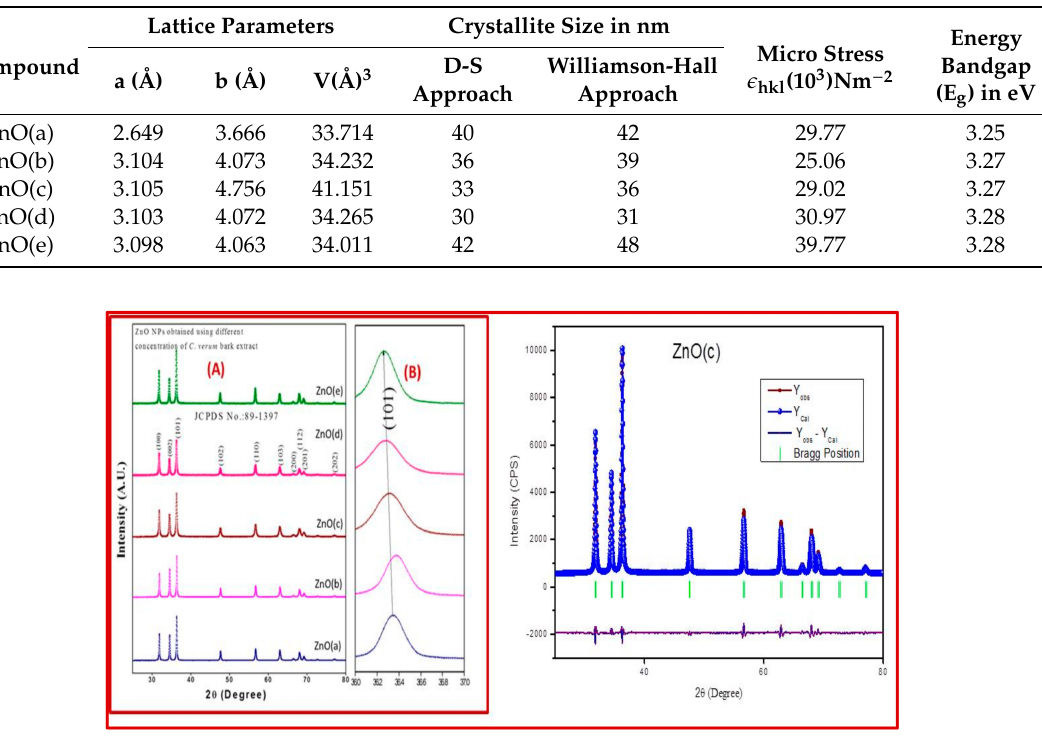
Figure 3. PXRD patterns of ZnO-NPs ( A ) and shift in the (101) plane obtained using various concentrationsof C. verum plant extract ( B ); Rietveld refined fitment showed for the ZnO(c) ( C ).